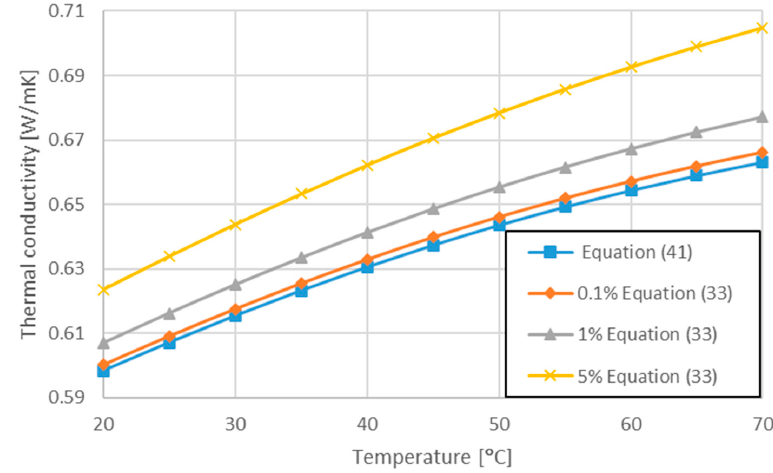
2 O 3 nanofluids.